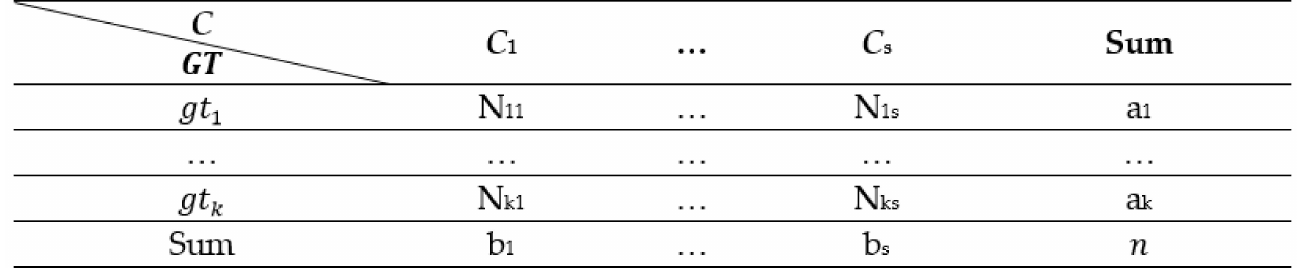
Figure 4. Contingency table for the computation of the adjusted Rand